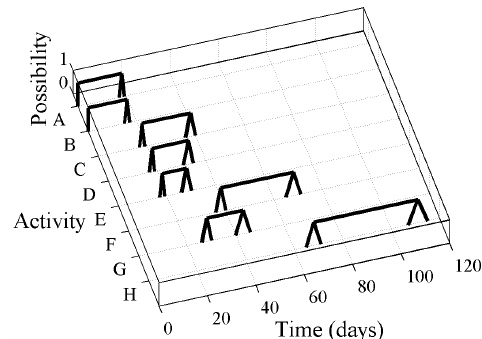
Fig. 10. Fuzzy Gantt Chart-3D without overlap